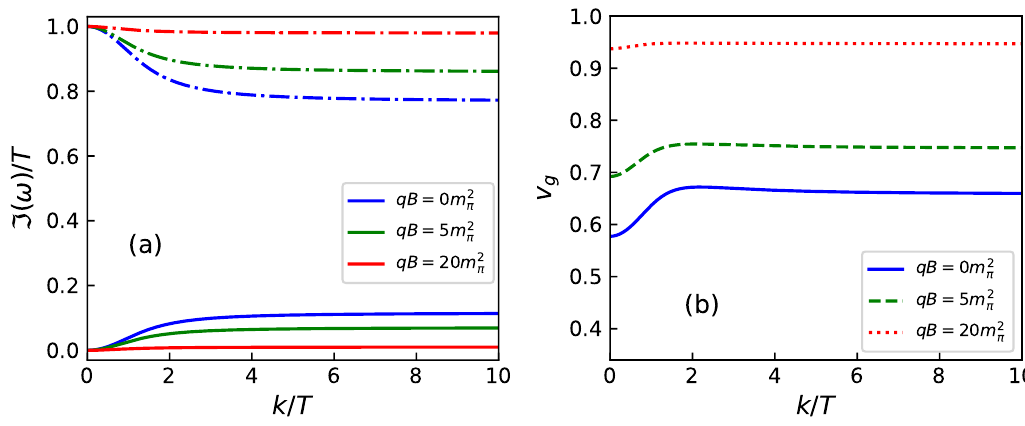
Figure 1 . (Color online) The imaginary parts of the dispersion relations obtain from eq. (4.27) for (cid:18) = (cid:25) with di(cid:11)erent magnetic (cid:12)elds denoted by di(cid:11)erent colors. The blue, green and red 2 colors correspond to B 0 = 0, 5 m 2 and 20 m 2 , respectively. In left panel the solid lines are for the (cid:25) (cid:25) propagating modes ( ! 2 ; 3 ) and the dashed lines are for the non-propagating mode ( ! 1 ). The other parameters used are a 1 = 0 : 1, (cid:11) = 1 = 3, T = 200 MeV, (cid:28) (cid:5) =0.985 fm and kept (cid:12)xed for all the